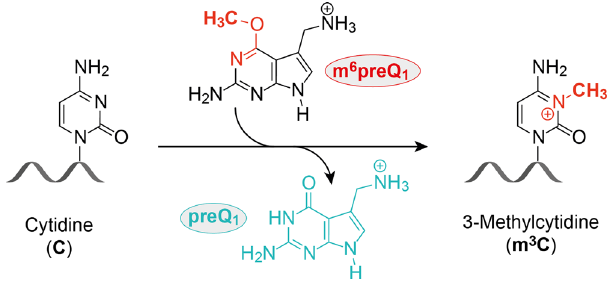
Fig. 1 RNA methyltransferase activity. RNA sequence-speci fi c installation of N3-methyl cytidine (m 3 C) using the small molecule m 6 preQ 1 as cofactor has been discovered and is described in this study. The direct link between a present-day riboswitch scaffold and RNA-catalyzed methylation is